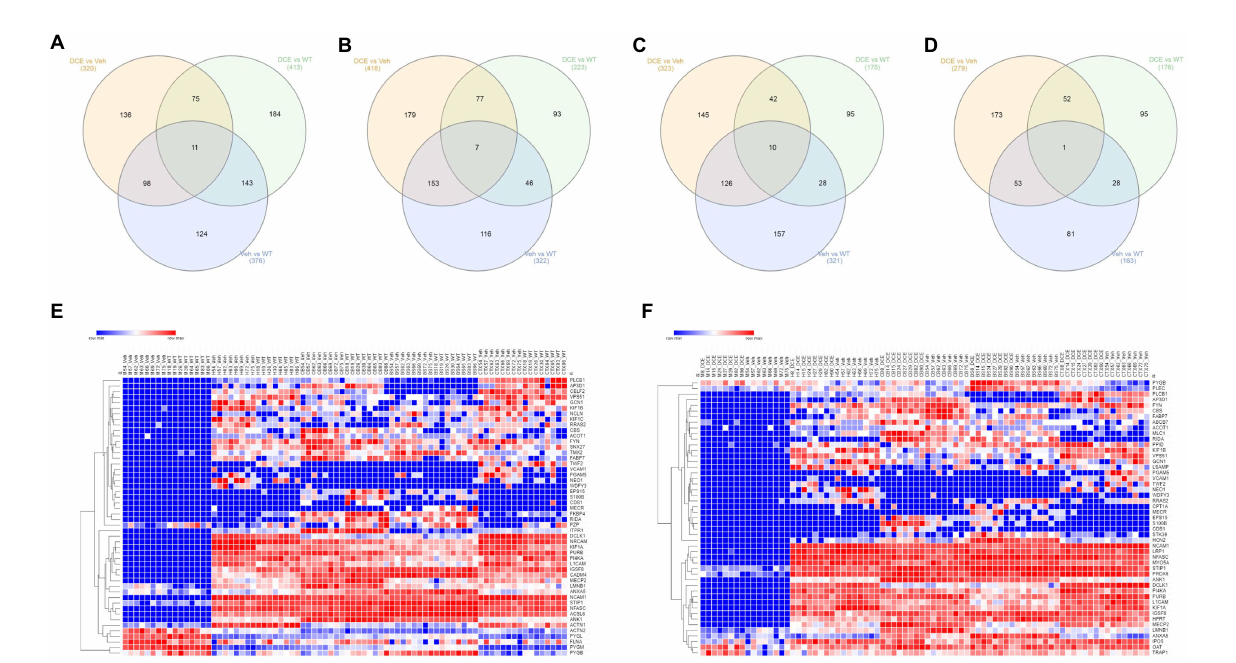
FIGURE 2 Comparison of proteomic signatures in different brain regions among the different experimental groups . (A–D) Venn diagram showing overlapping proteins among the three experimental groups. The proteins that showed a significant change in abundance in CrT KO mice compared with the WT and in DCE-treated mice compared with vehicle-treated mice were selected for pathway analysis. The proteins that showed a change in abundance in the vehicle-treated mice and the DCE-treated mice compared with the WT mice were also selected for pathway analysis. The abundances of these proteins in the cortex, cerebellum, brainstem, hippocampus and muscle were analyzed using a multivariate statistical model based on one-way ANOVA followed by Bonferroni’s post hoc test. (E) Heatmap showing the proteins that showed a significant change in abundance in vehicle-treated CrT KO mice compared WT mice. (F) Heatmap showing the proteins that showed a significant change in abundance in DCE-treated CrT KO mice compared with vehicle-treated CrT KO